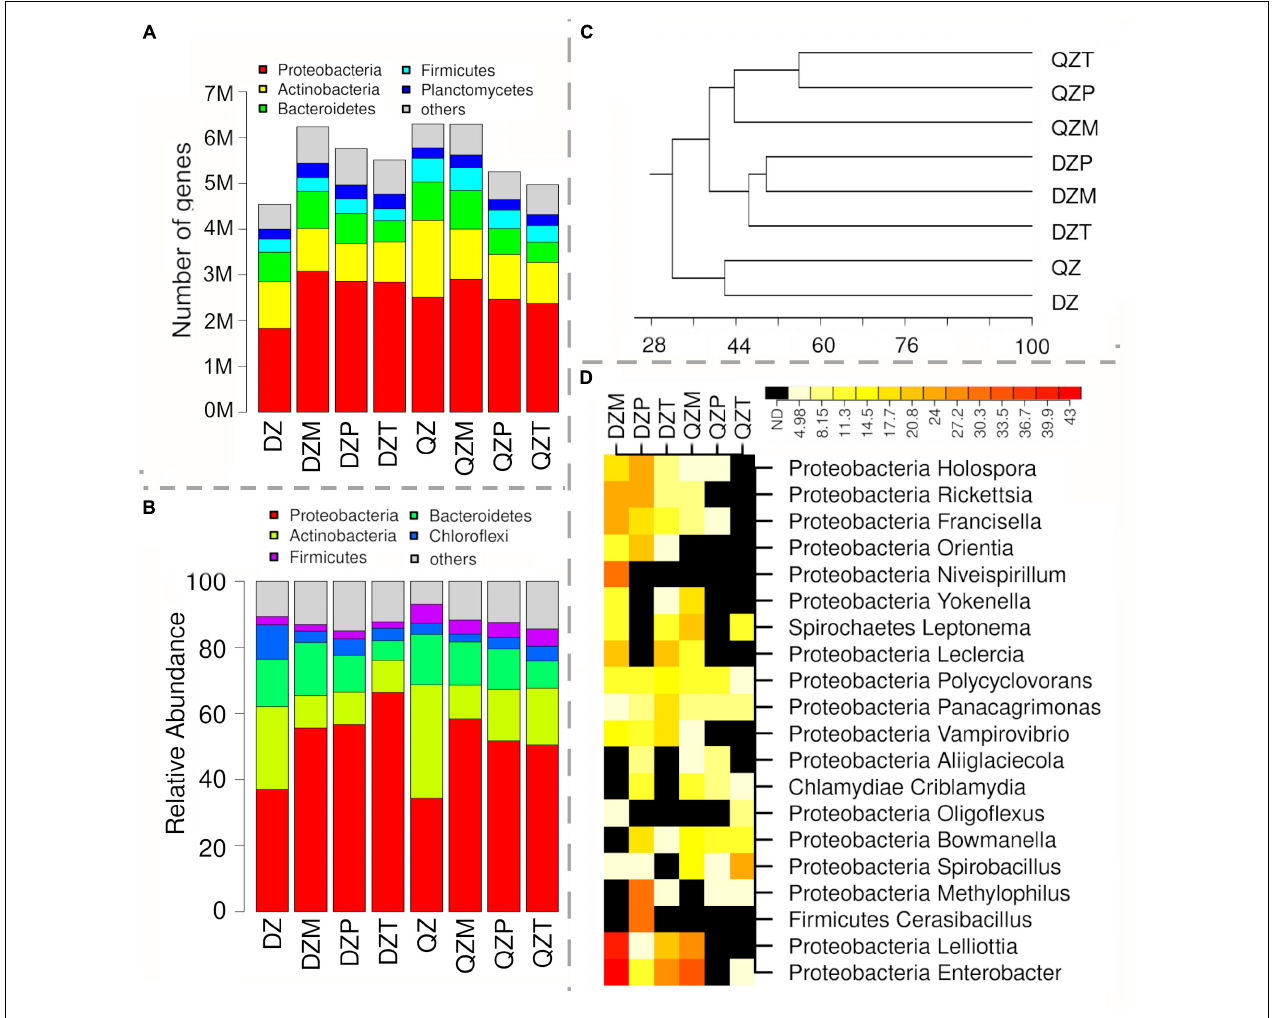
FIGURE 3 | Microbial community as revealed by functional gene clusters using shotgun metagenomics. The amounts expressed in million (A) and relative abundance (B) of functional gene clusters affiliated to different phyla, difference in functional gene clusters between rhizosphere (C) and compost and the top 5 genera most enriched in the rhizosphere as indicated by log2 of fold increase in gene abundance (D)